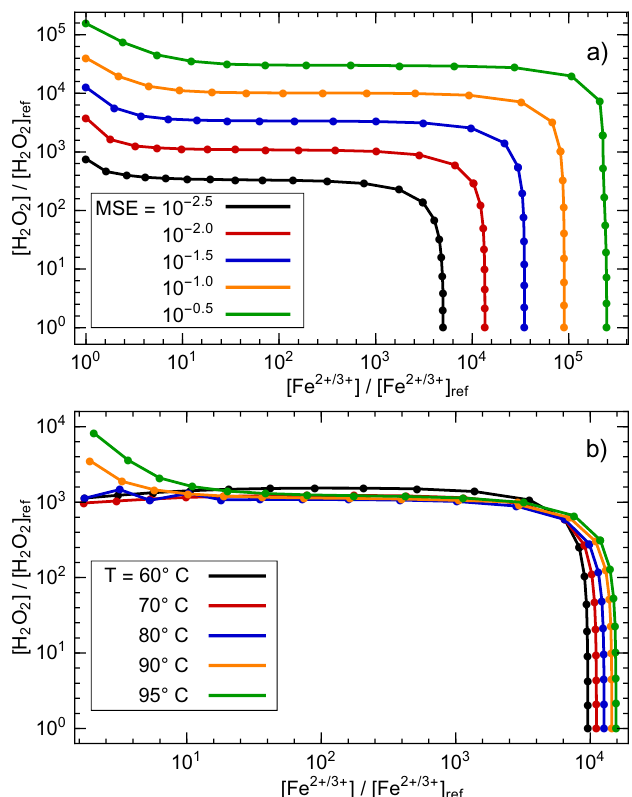
Figure 4. Robustness of the reduced model towards the changes in model boundary conditions. ( a ) Discrepancy between the full model (FM) and the reduced model (RM), expressed as MSE value, at T = 90 ◦ C, as a function of iron ion and hydrogen peroxide concentration. ( b ) Limiting values of iron ion and hydrogen peroxide concentration at which MSE = 10 − 2 at different temperatures. Both figures indicate that low values of MSE are maintained for a wide range of model boundary